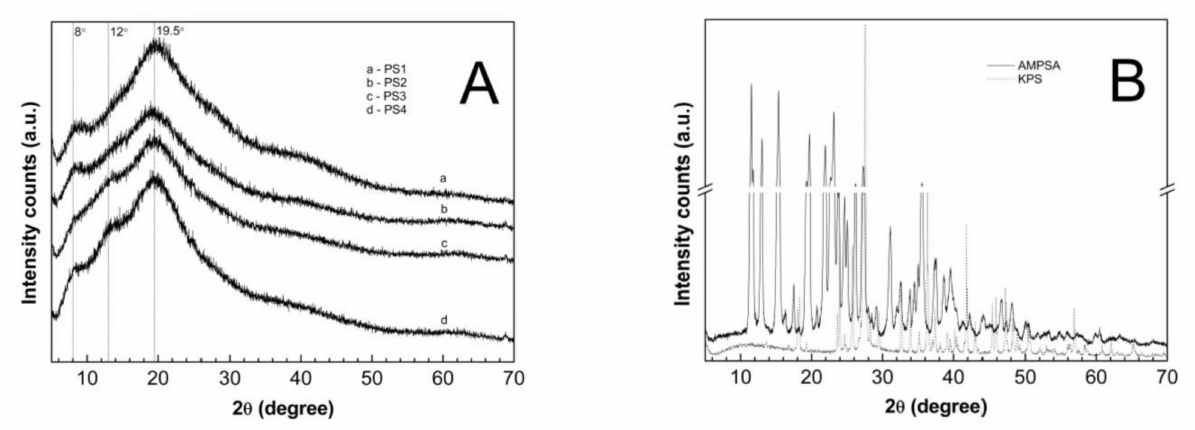
Figure 13. ( A , B ) Powder X-ray diffraction patterns of ( A ) synthesized PS1–PS4 polymers; ( B ) monomer–AMPSA and initiator–KPS. Table 4. Intensities of selected diffraction peaks for the investigated samples; 2 θ = 5–70 ◦ .